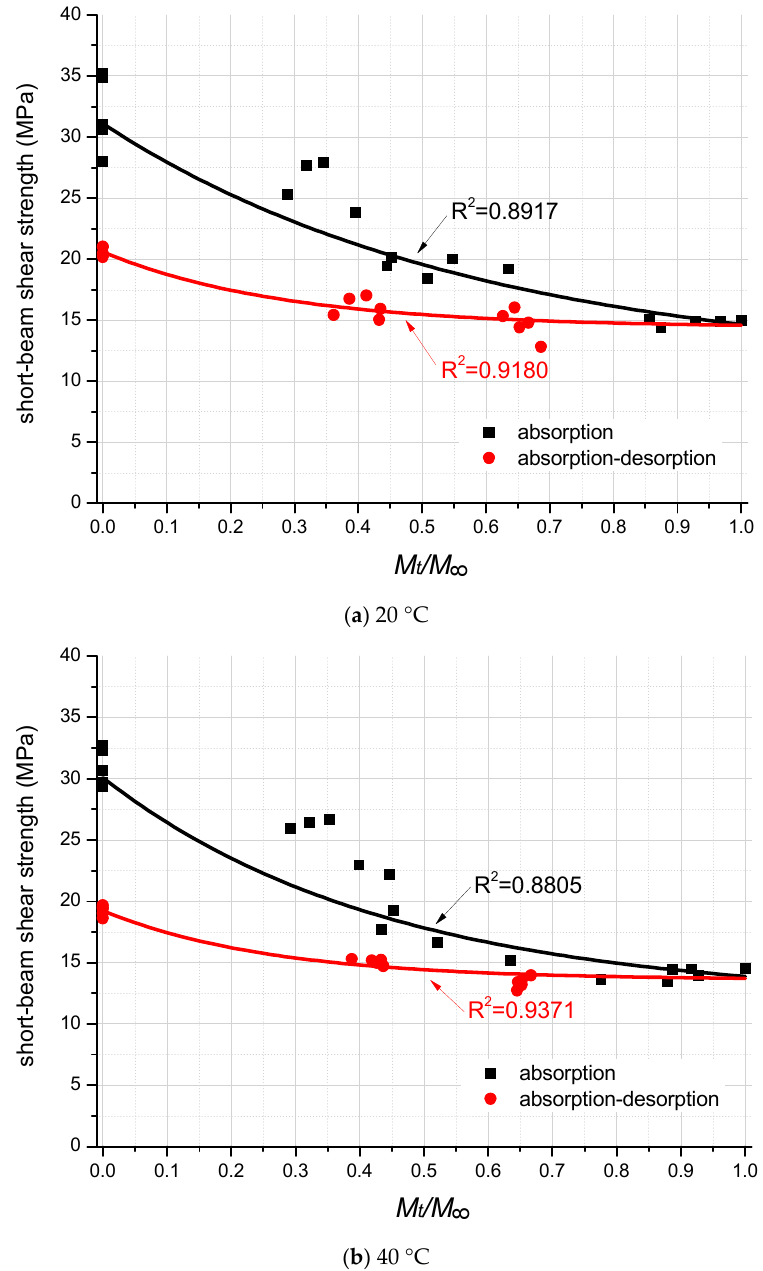
Figure 7. Degradation on the short-beam shear strength of FRP laminates.